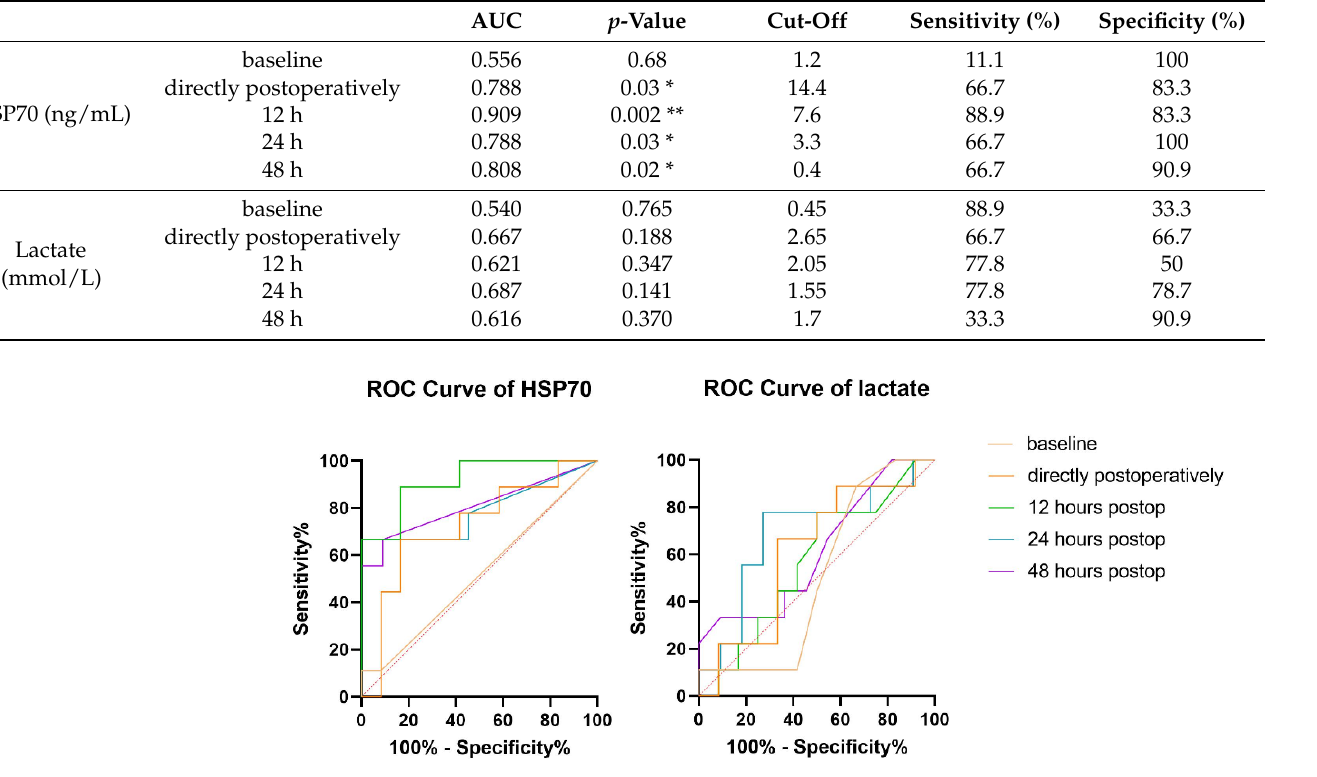
Figure 3. ROC curves for heat-shock protein 70 (HSP70) serum levels and lactate.